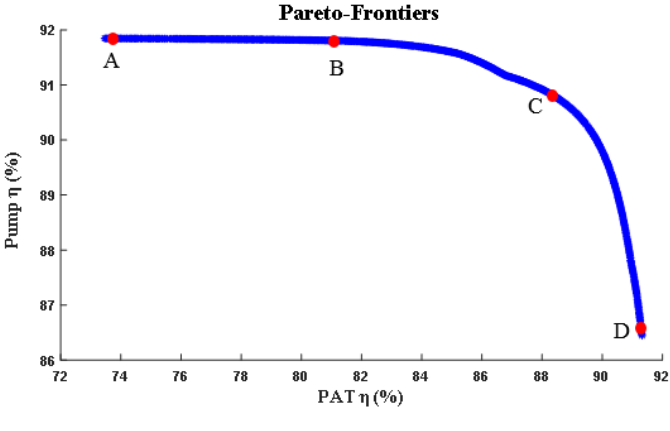
Figure 18. Pareto ‐ frontiers. Figure 18. Pareto-frontiers.